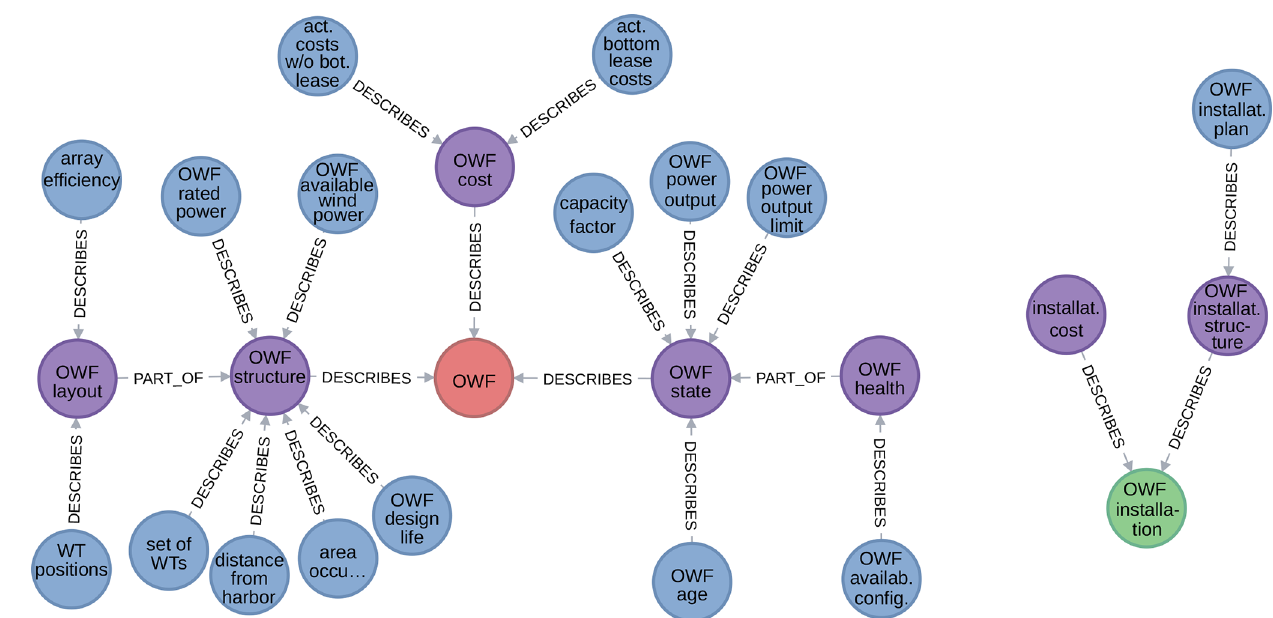
Figure 8. Excerpts from WESgraph of the subgraph defined by the DESCRIBES